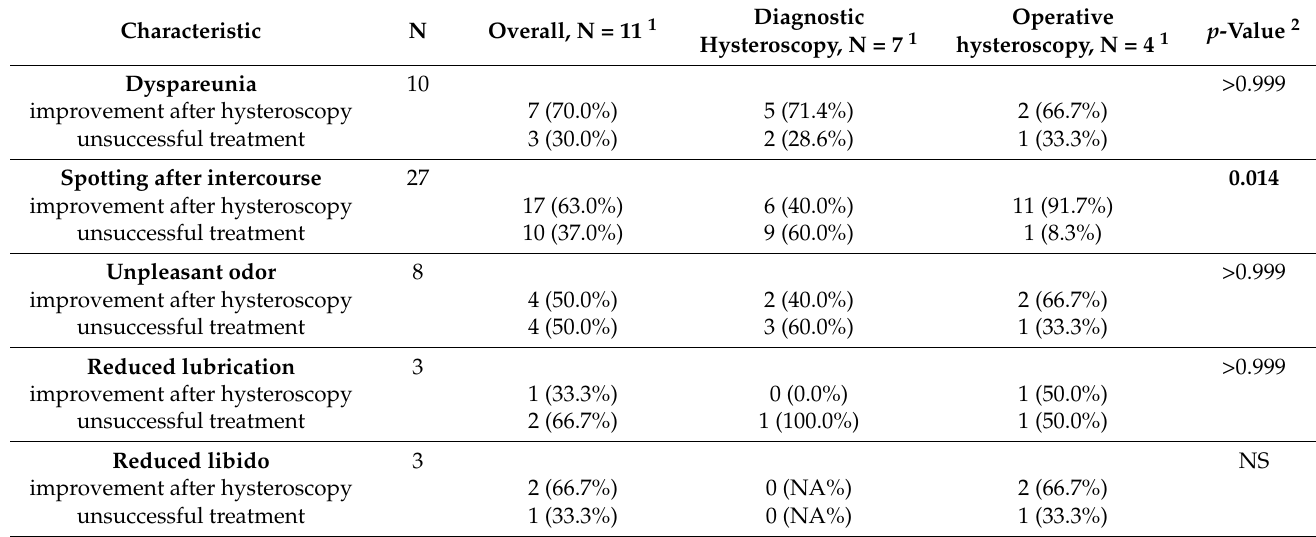
Table 4. The diagnostic vs. operative hysteroscopy and their influence on sexual